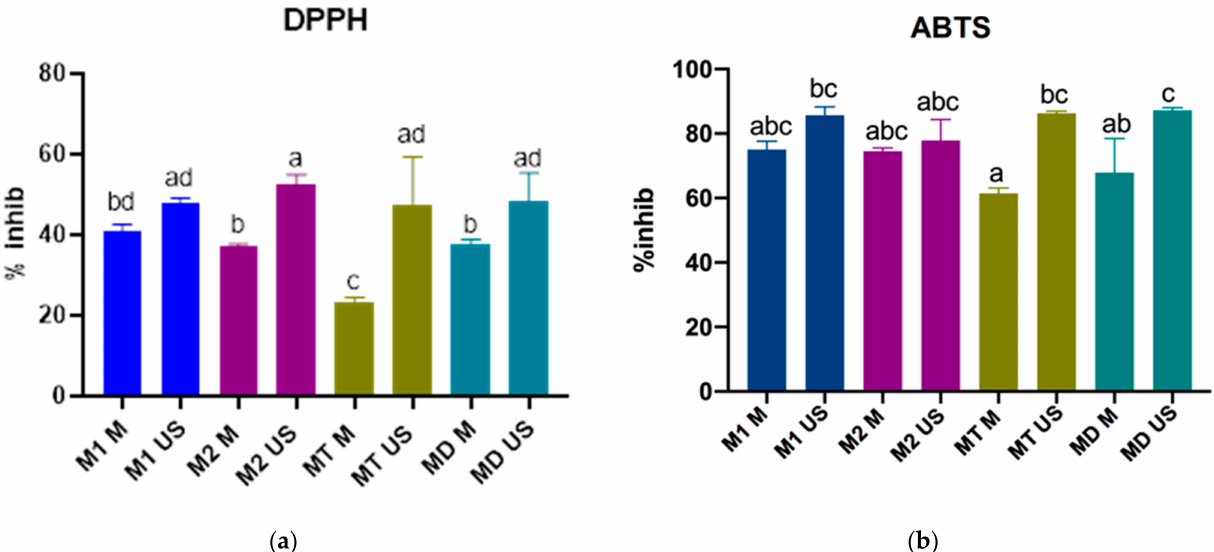
Figure 2. ( a ) Antioxidant capacity (AC) assessed by the DPPH method; ( b ) antioxidant capacity (AC) assessed by the ABTS method; significant differences are represented by different letters (significance level α = 0.05); M1 US— P. abies (Maramures ului mountains national park site 1) extract produced by UAE, M2 US— P. abies (Maramures ului Mountains , , National Park site 2) extract produced by UAE, MT US— P. abies (Tas ca) extract produced by UAE, MD US— P. abies , (Dolhasca) extract produced by UAE, M1 M— P. abies (Maramures ului Mountains National Park site 1) extract produced by , MAE, M2 M— P. abies (Maramures ului Mountains National Park site 2) extract produced by MAE, MT M— P. abies (Tas ca) , , extract produced by MAE and MD M— P. abies (Dolhasca) extract produced by